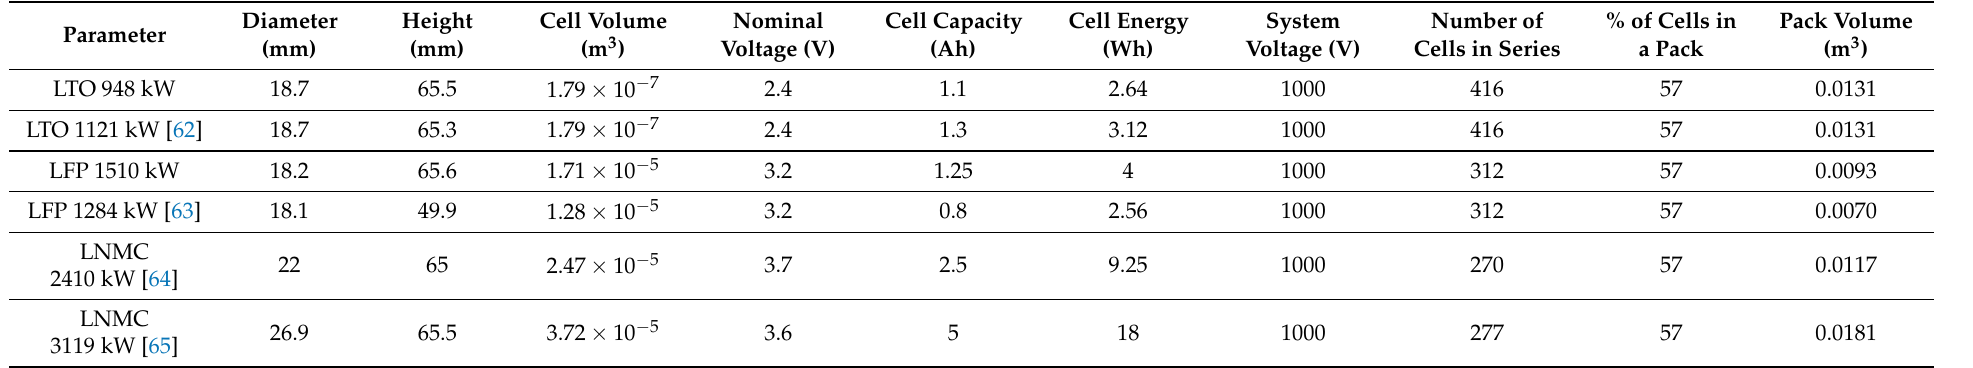
Table 5. Battery pack